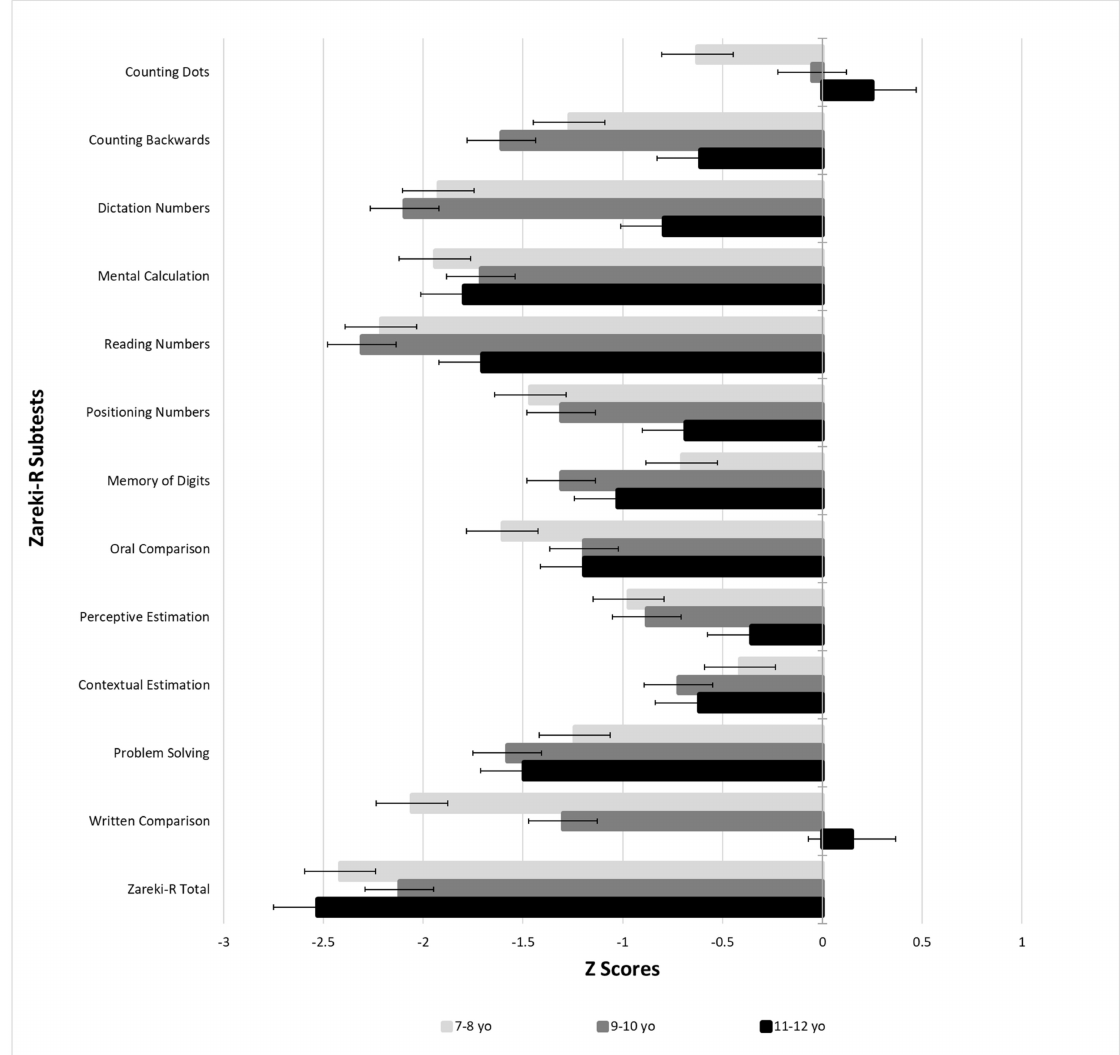
Figure 1. Performance on Zareki-R of the children with DD (N = 22), per age